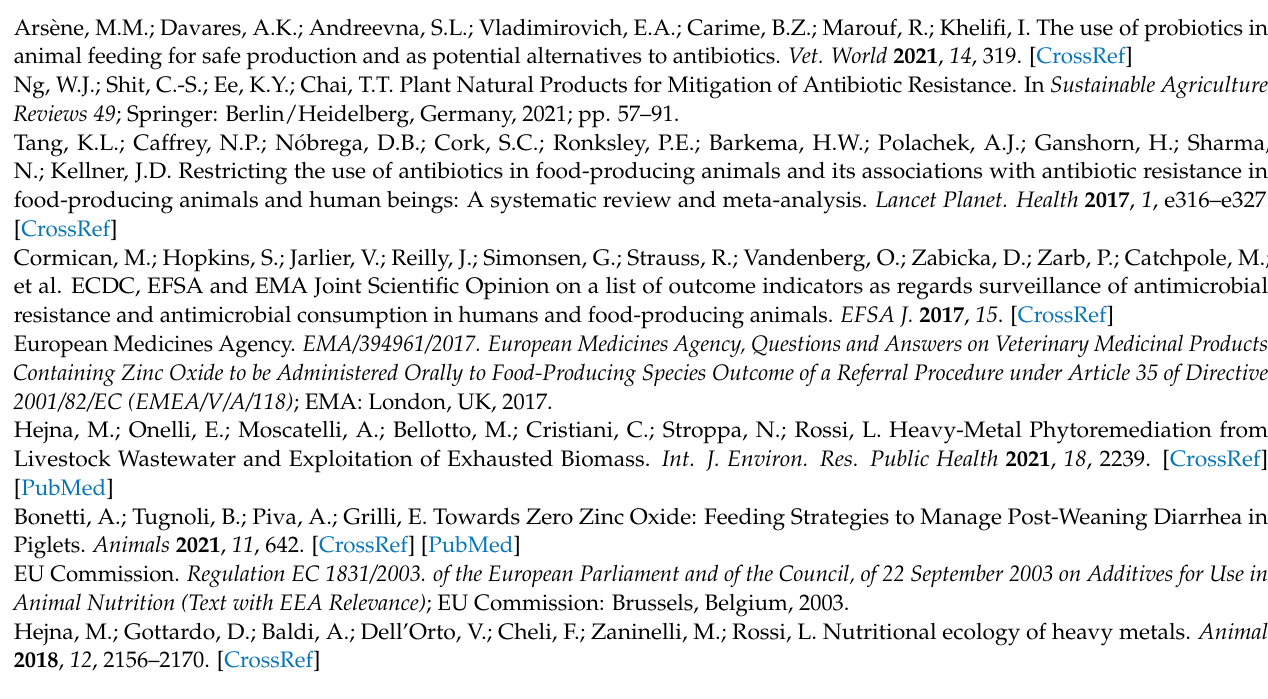
Figure S2: Agarose gel electrophoresis of L. reuteri PCR reaction products, Table S1: MIC concentra- tions ( µ g/mL) obtained for L. plantarum and L. reuteri strains and cut-off values proposed from EFSA guidance on the assessment of bacterial susceptibility to antimicrobials of human and veterinary importance, Table S2: Obtained biomass from small-scale fermentations and viability of L. plantarum and L. reuteri, Table S3: Obtained biomass and relative viability of freeze-dried L. reuteri and L. plantarum , Table S4: Bacterial fermentation for experimental trial batch production, Table S5: Serum metabolites concentration at 0 days (T0) of in vivo trial, for the control (CTRL) and treatments groups (PLA, REU and